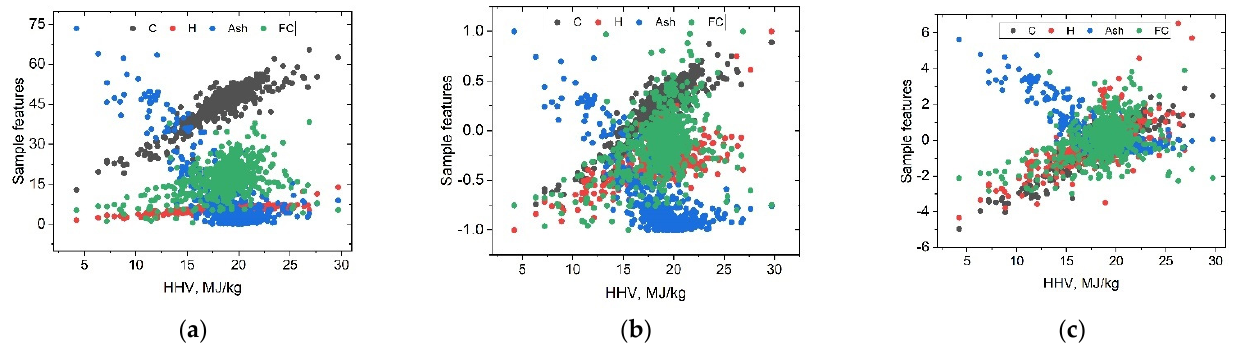
Energies 2022 , 15 , x FOR PEER REVIEW